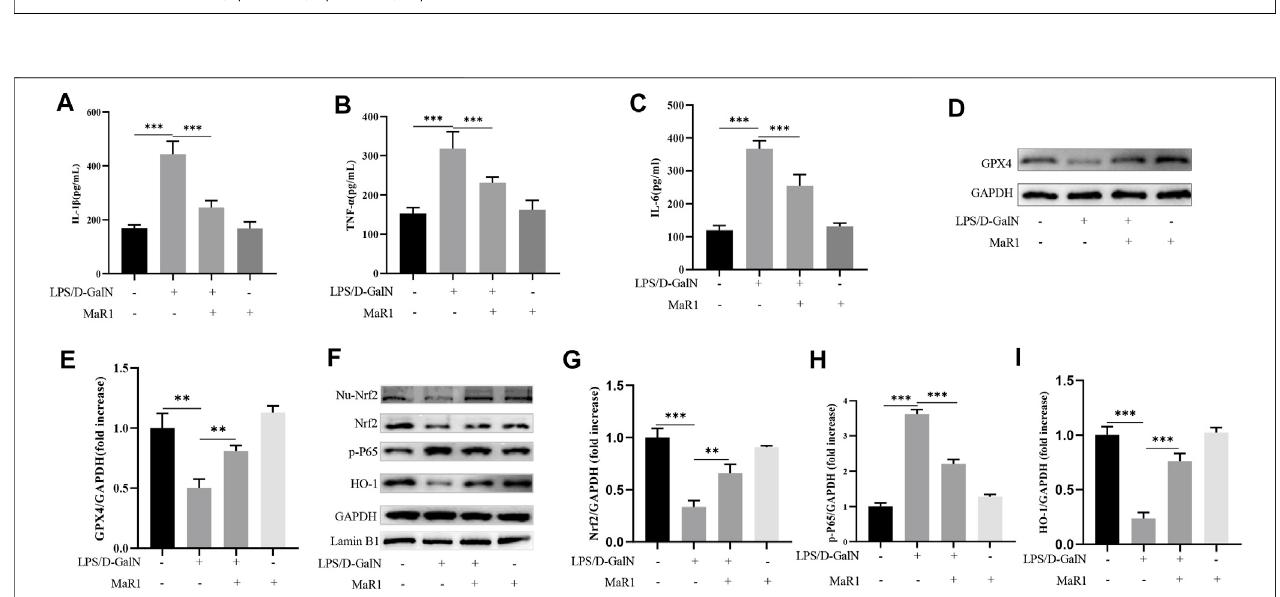
FIGURE 4 | MaR1 inhibited ferroptosis-induced liver injury through proin fl ammatory factors inhibition and Nrf2/HO-1/GPX4 activation. (A – C) MaR1 signi fi cantly reducedtheincreaseinserumIL-1 β ,TNF- α ,andIL-6levelscausedbyD-GalN/LPS. (D,E) WesternblotshowedthatD-GalN/LPSsigni fi cantlyinhibitedtheexpressionof GPX4, and MaR1 attenuated this change. (F – I) Western blot showed MaR1 treatment signi fi cantly promoted the expression of Nrf2 and HO-1, and inhibited the expression of p-P65. Data are shown as the mean ± SD, * p < 0.05; ** p < 0.01; *** p <